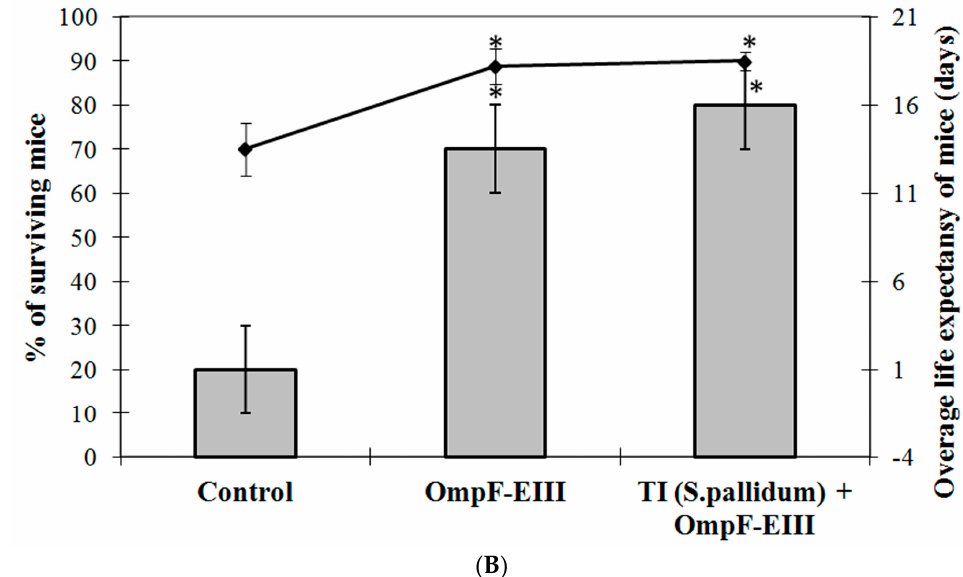
Figure 4. Protective activity of OmpF-EIII alone and OmpF-EIII incorporated into the TI-complex (TI ( S. pallidum ) + OmpF-EIII). ( A ) Number of mice surviving post infection with the tick-born encephalitis virus (TBEV) in groups of animals previously immunized twice with the OmpF-EIII alone (OmpF-EIII) and OmpF-EIII incorporated into the TI complex (OmpF-EIII + TI). Control represents a group of animals infected with TBEV without previous immunization. Each group contained ten animals. The duration of observation was 21 days post infection. ( B ) Percentage of survival (bars) in groups of animals: Control, OmpF-EIII, and TI ( S. pallidum ) + OmpF-EIII. Average life expectancy (line graph) in groups of animals: Control, OmpF-EIII, and TI ( S. pallidum ) + OmpF-EIII. Values are means ± SE for three independent experiments. The Fisher exact test was used to compare the protective activity in mice groups with the control. * p < 0.05 as compared with the control.